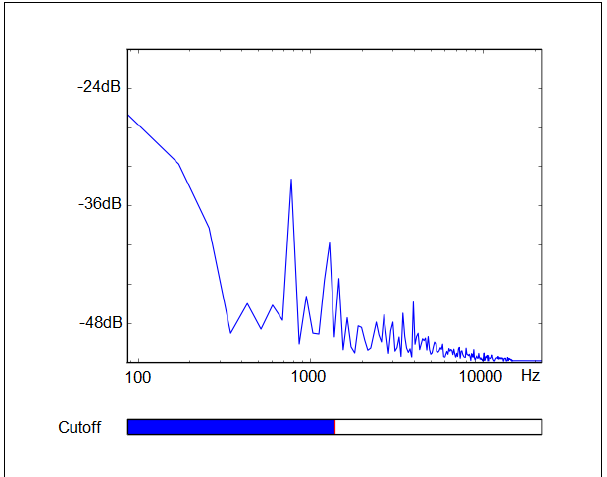
Figure 1. Real-time spectrum of the output signal and low-pass filter cutoff parameter